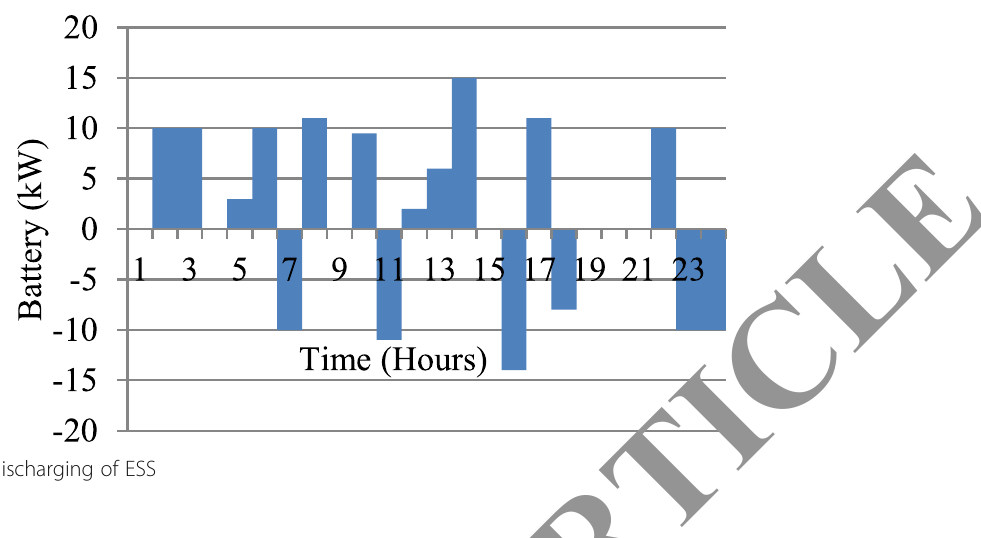
Fig. 10 Charging and discharging of ESS